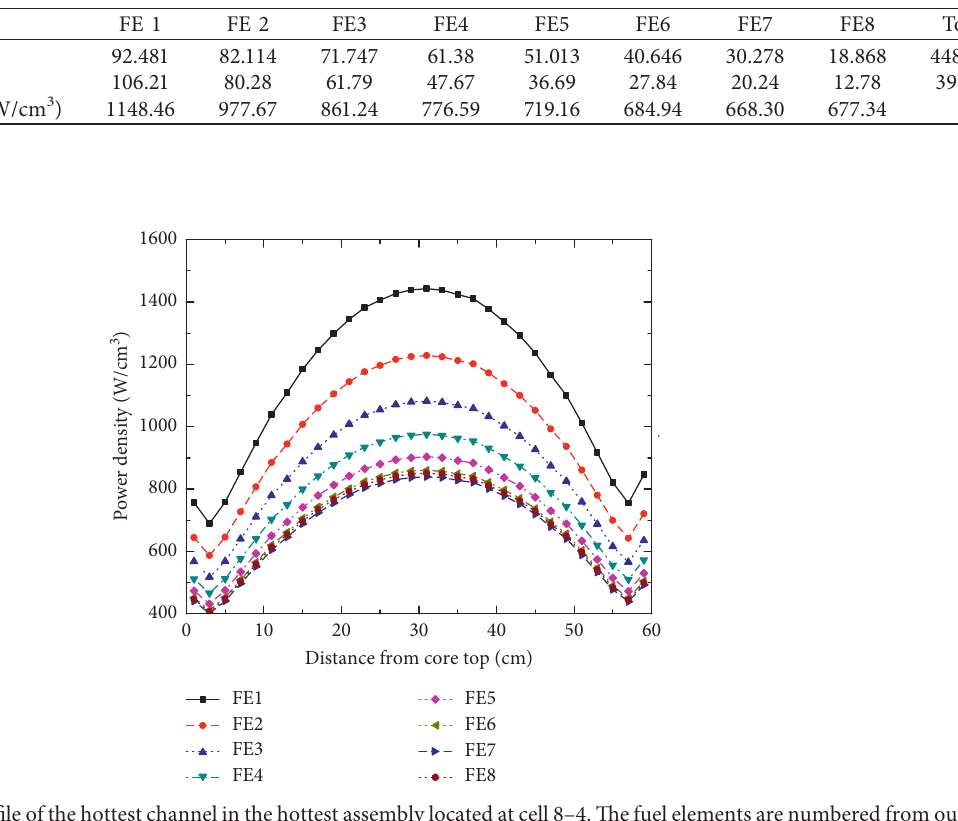
Table 2: Power rates in the fuel elements of the hottest fuel assembly. The fuel elements are numbered from outer to inner elements in the assembly.